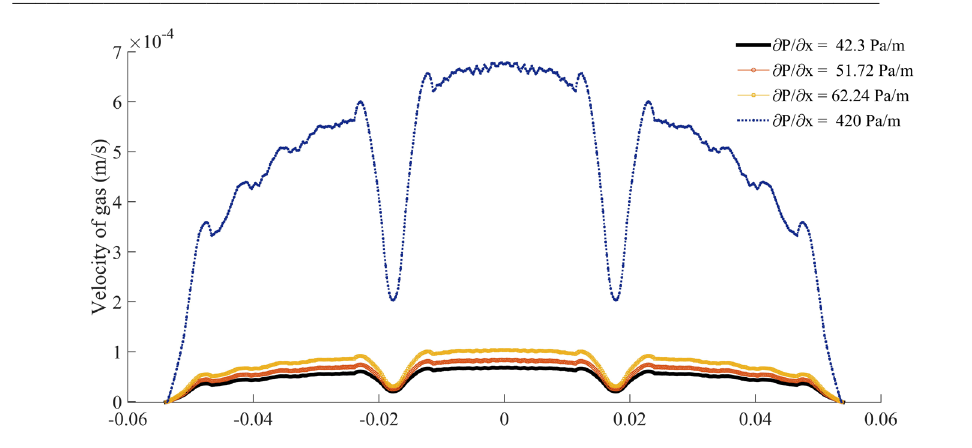
Fig. 7. The effect of pressure gradient on the velocity profile of gas at constant dynamic viscosity (μ) and lattice speed of sound (cs).